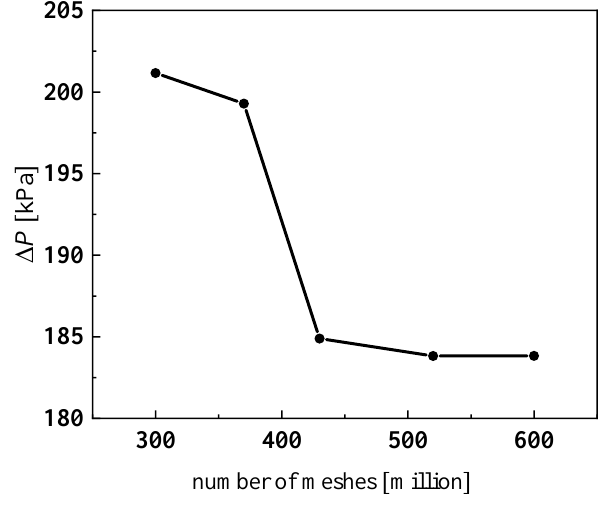
Figure 8. Grid partition.